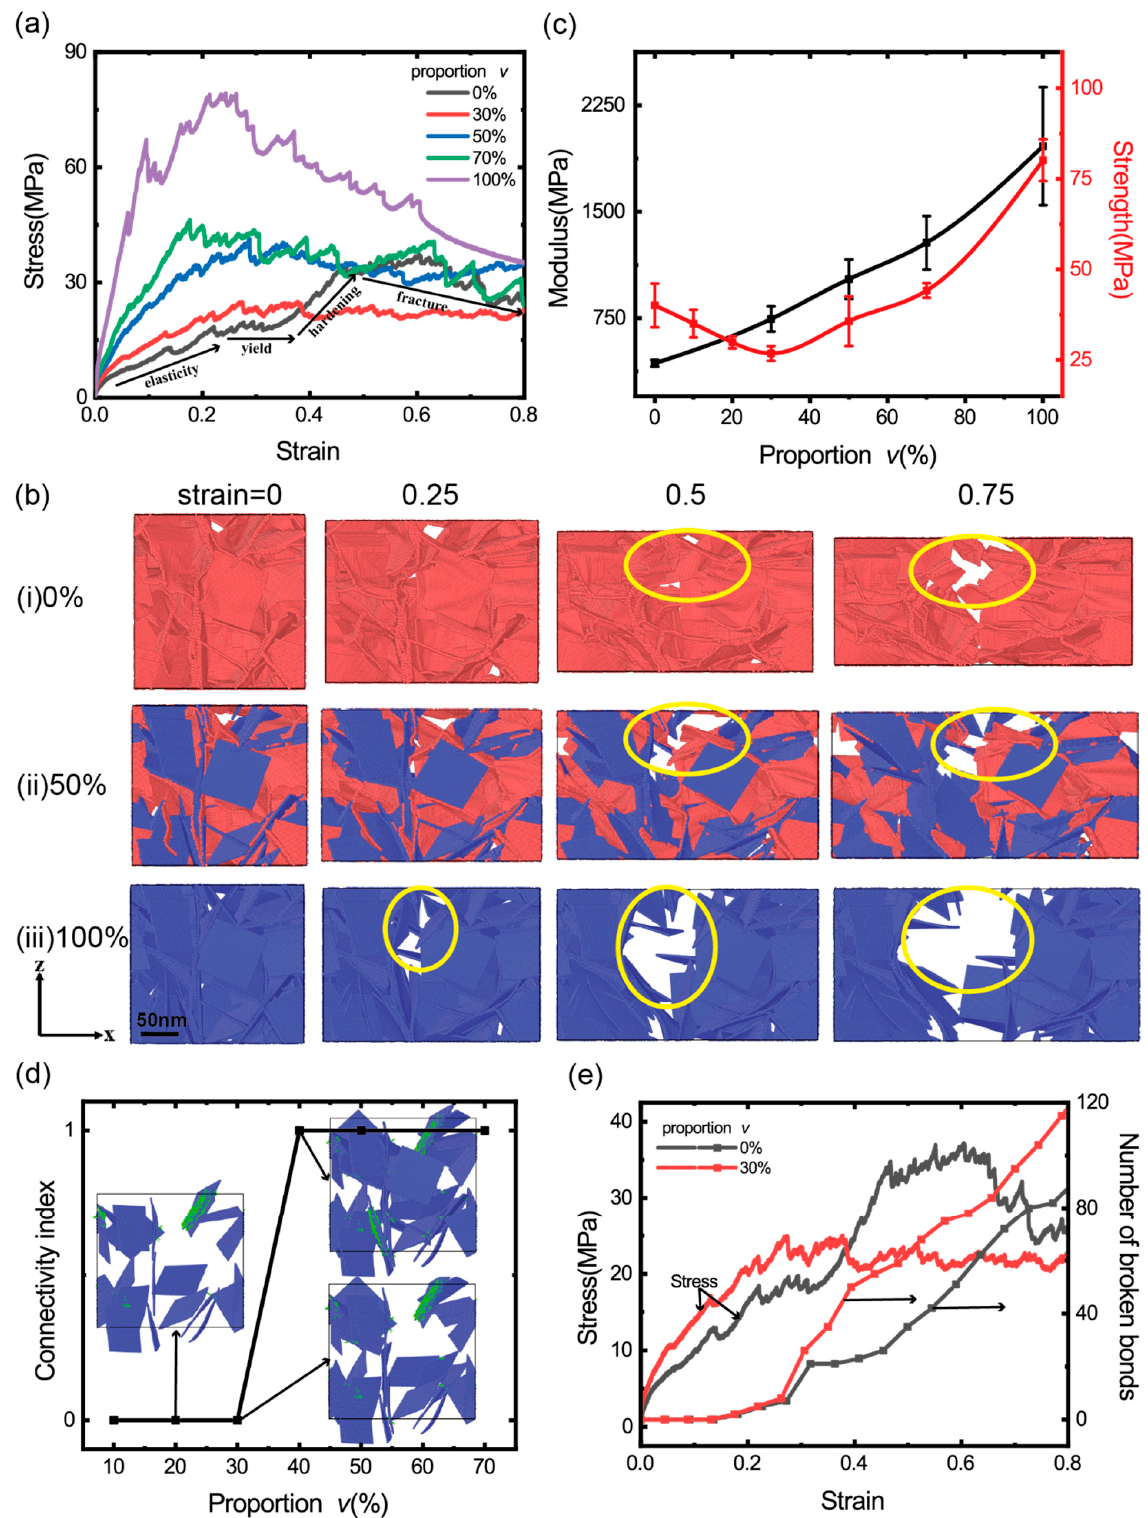
Figure 2. ( a ) The uniaxial tensile stress–strain curves of the GrFs with varied proportions of 8-layer stiff sheets v = 0, 30%, 50%, 70% and 100%; ( b ) The snapshots of the microstructural evolution of the GrFs with v = 0, 50% and 100% at four tensile strains of 0, 0.25, 0.5 and 0.75, respectively; ( c ) The modulus and strength of the GrFs as a function of the proportion of stiff sheets. ( d ) The connectivity of the GrFs with varied proportions of stiff sheets (The connectivity of the system is set to be 1 if the connected stiff sheets can run through the entire system in the loading direction; otherwise, it is 0); ( e ) The stress and the number of broken bonds in the GrFs with v = 0 and 30% as a function of tensile strain.